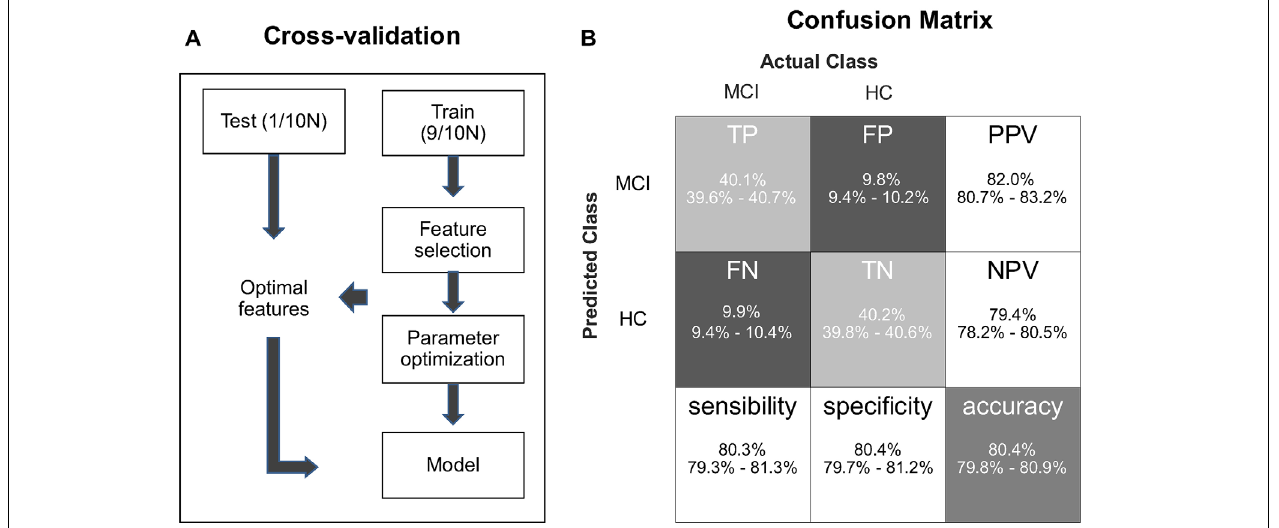
FIGURE 2 | (A) A flowchart describing the protocol of cross-validation in support vector machine (SVM) learning. (B) The confusion matrix of classification results, which indicates true positive (TP), false positive (FP), positive predictive value (PPV), false negative (FN), true negative (TN), negative predictive value (NPV), sensitivity, specificity, and